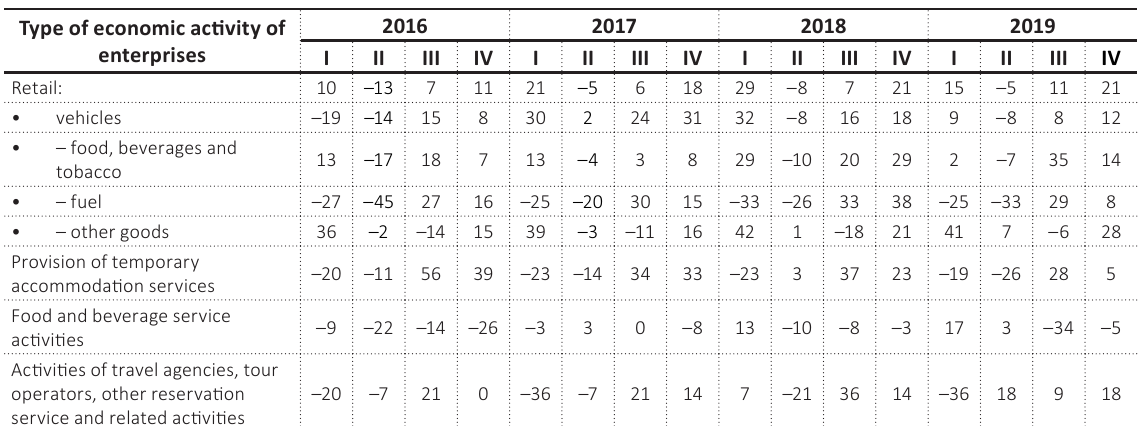
Table 1. Expected changes in sales of goods (services) by enterprises (% of the total number of enterprises) in